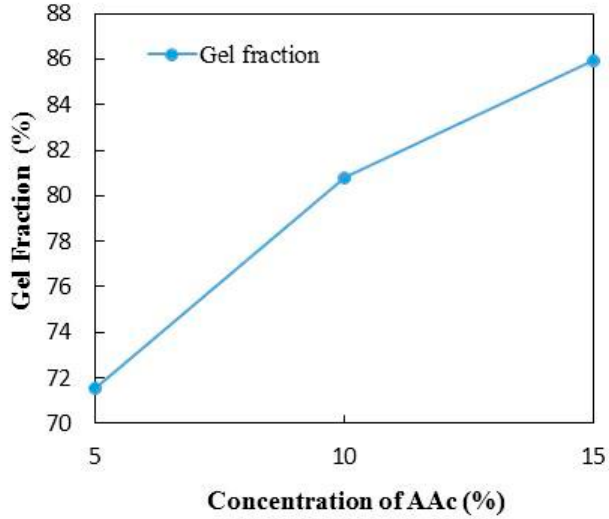
Figure 6. Effect of AAc concentrations on gel fraction of PA hydrogels prepared at radiation dose 30 kGy.